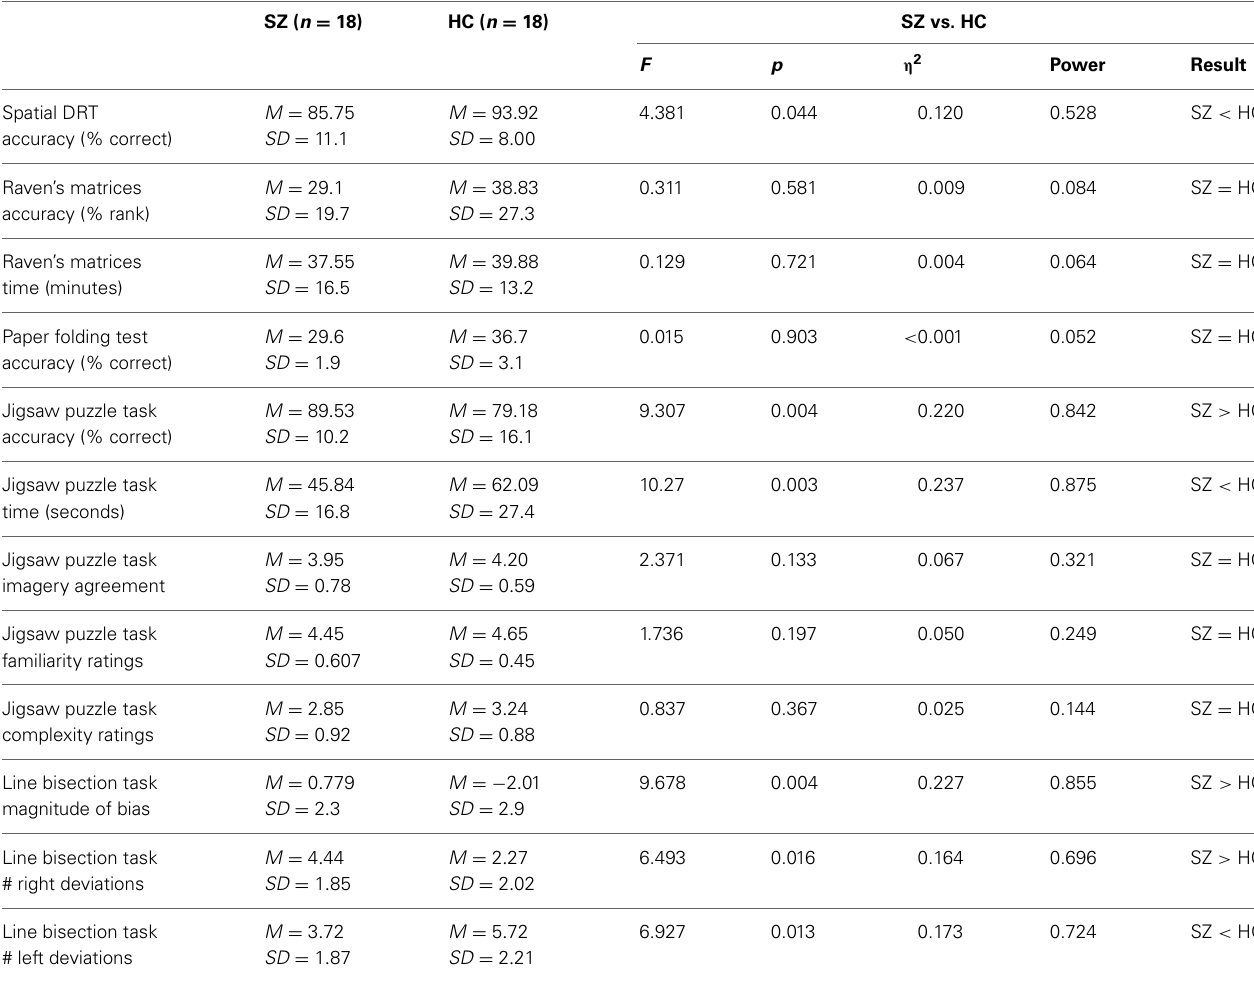
Table 2 | Summary of between-group